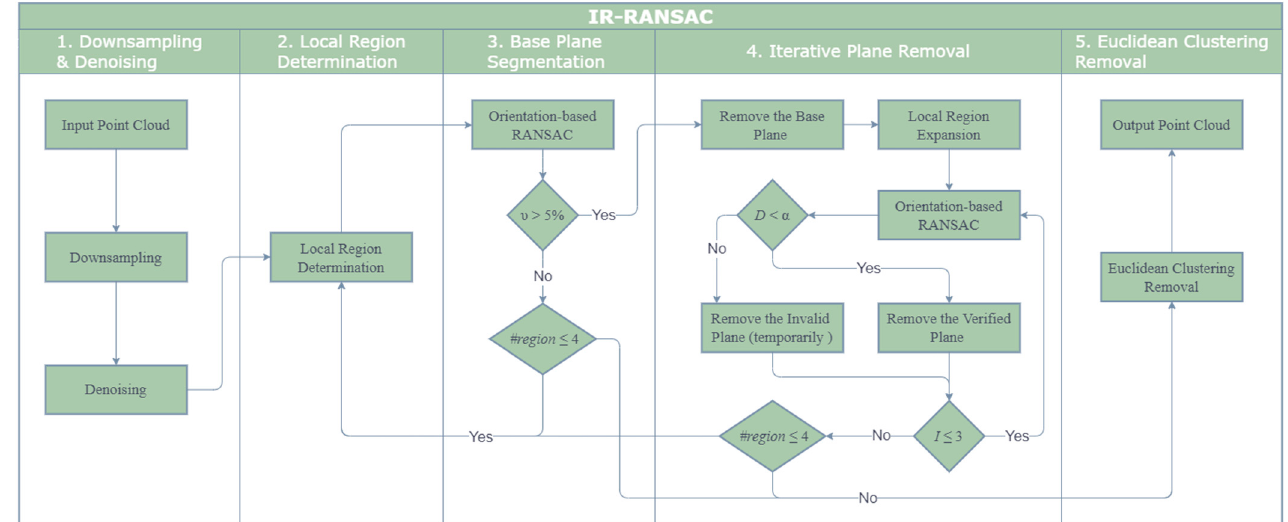
Figure 1. The flowchart of IR ‐ RANSAC.